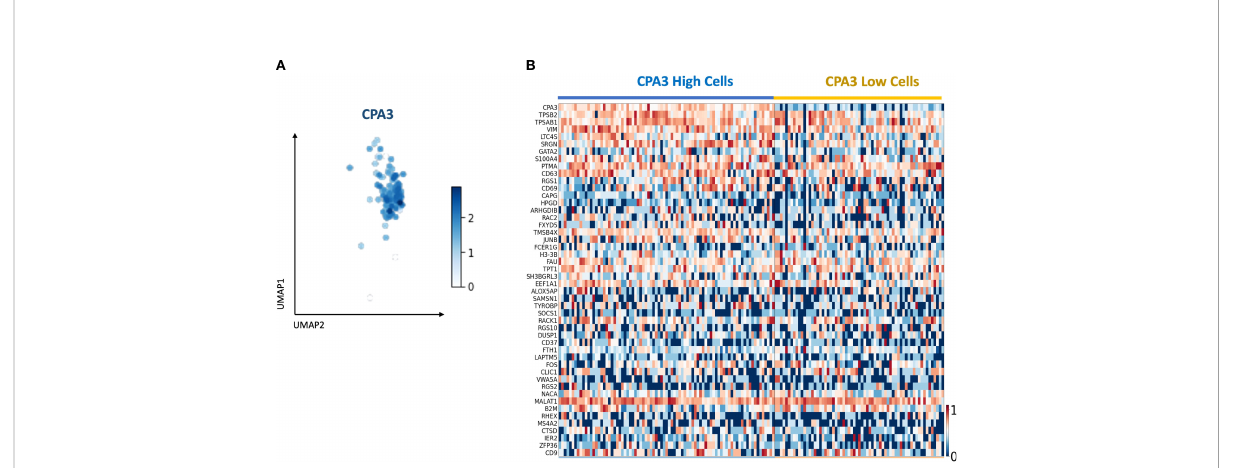
FIGURE 8 Single-cell RNA sequencing identi fi es a mast cell population with CPA3 high and low gene expression. (A) UMAP of the subset of mast cells determined by the expression of commonly known last cell markers (TPSB2, TPSAB1, MS4A2, and CPA3). CPA3 expression is shown. (B) Gene expression heatmap showing cells with “ high ” and “ low ” CPA3. Cells were considered “ high ” when CPA3 expression was above 1.5 and “ low ” when CPA3 expression was below or equal to 1.5. The genes on the y -axis are the top 48 upregulated genes within the mast cell